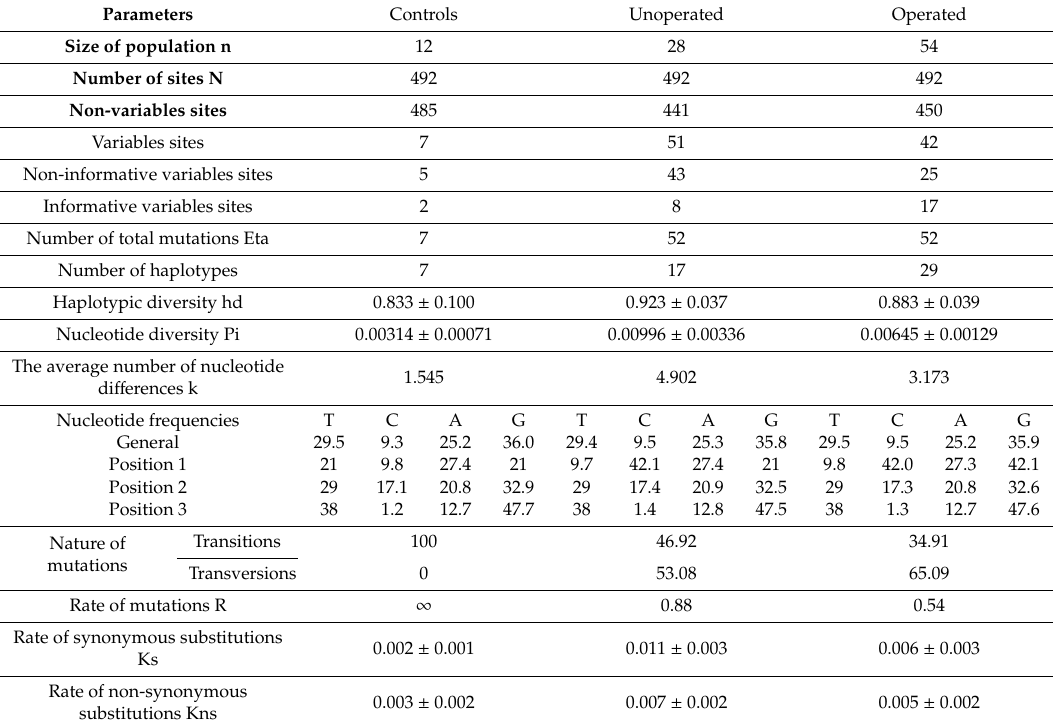
Table 3. Parameters for genetic diversity of the study